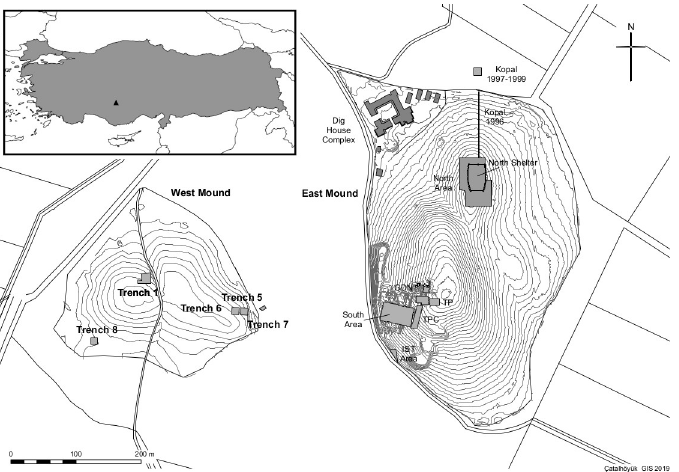
Fig 1. Plan of C¸atalho¨yu¨k. Site’s location and plan map of the west mound and the north and south areas on the east mound (after Camilla Mazzucato; C¸atalho¨yu¨k Research Project).